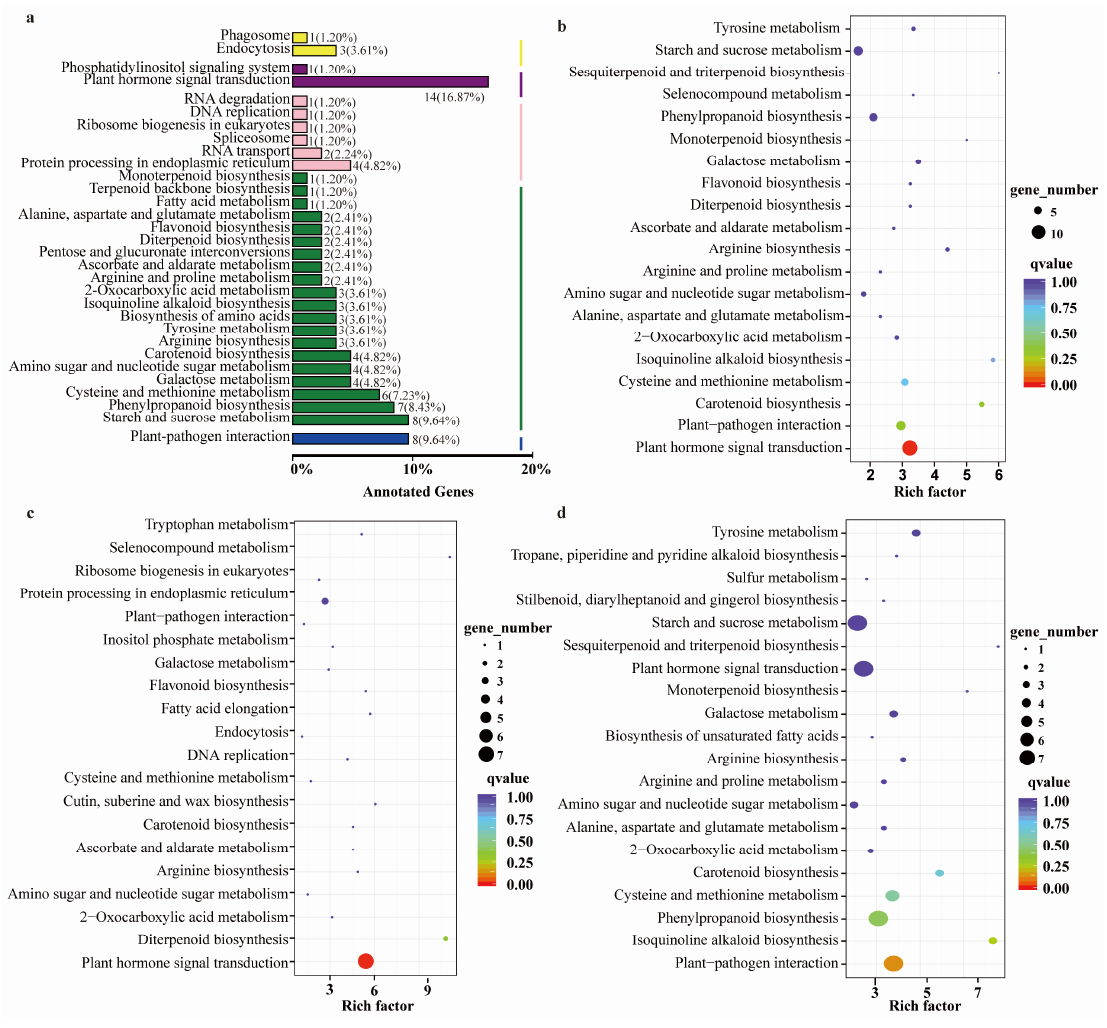
Figure 3. KEGG pathway enrichment for DEGs. ( a , b ): The top enriched KEGG pathway for all DEGs. ( c , d) : The top enriched KEGG pathway of down-regulated DEGs and up-regulated DEGs, respectively. Table 3. Genome sequencing information of the mapping population for mutant